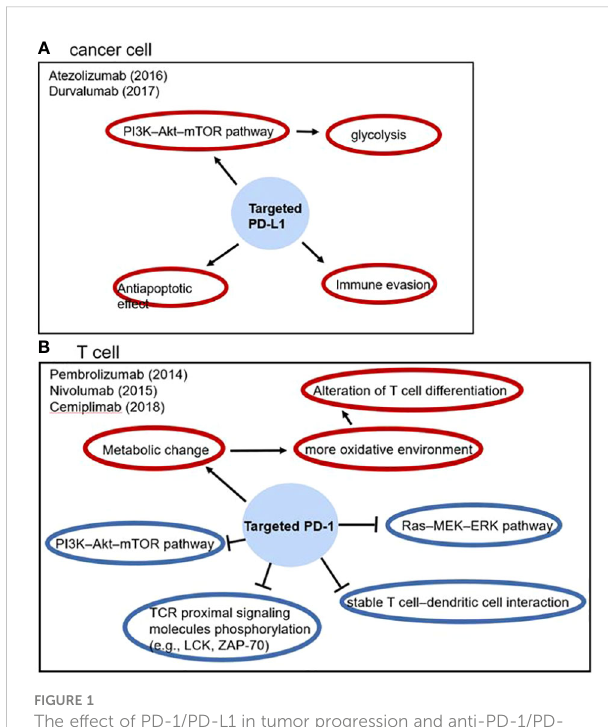
FIGURE 1 The effect of PD-1/PD-L1 in tumor progression and anti-PD-1/PD- L1 drugs, blue circles represent inhibitory effects and red circles represent stimulatory